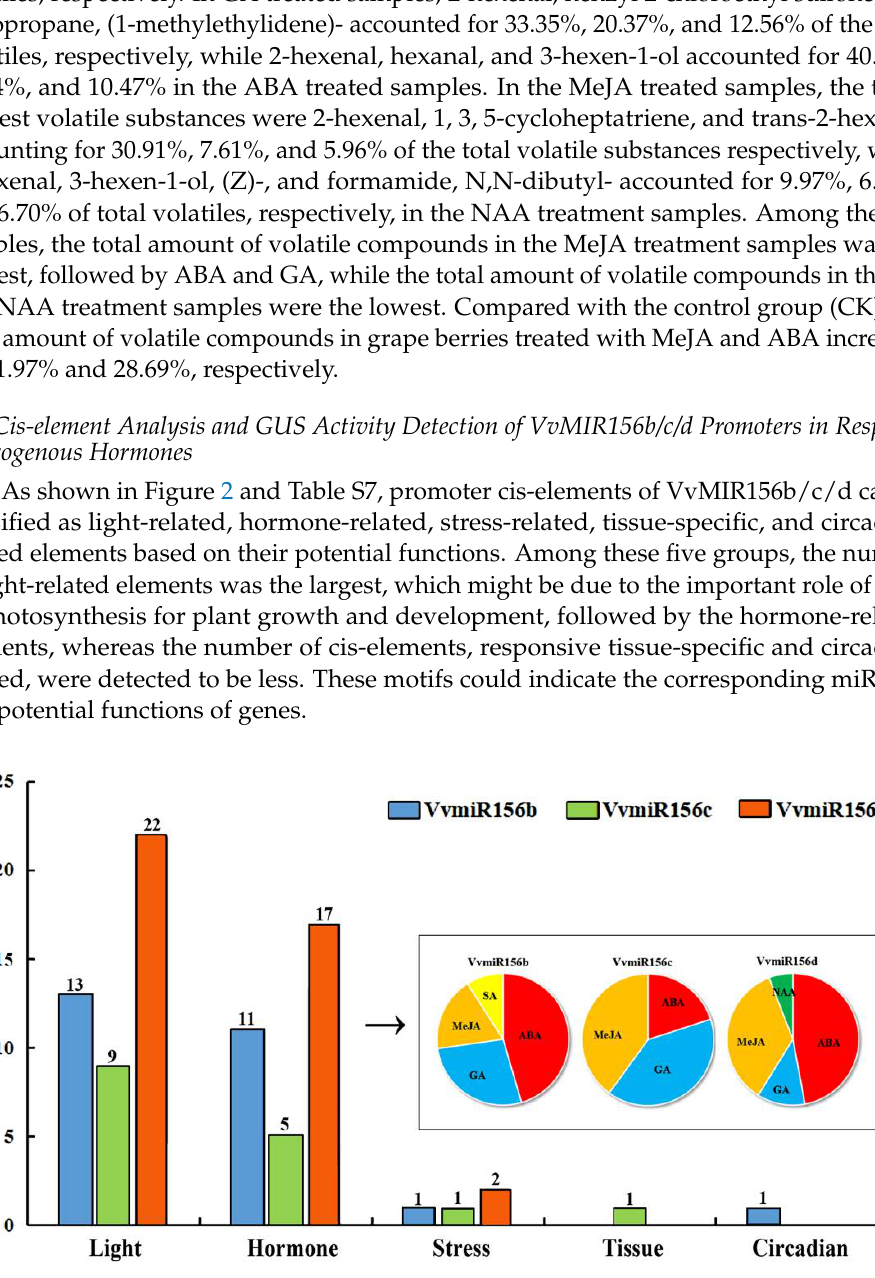
Figure 2. Motif analysis of the VvMIR156b/c/d promoters. Hormone-related motifs in their promoter regions were scanned and it was found that almost all VvmiR156b/c/d had similar hormones-related motifs including the ABA, GA, and MeJA responsive motifs (Figure 2). Furthermore, the SA-responsive element (TCA-element) and auxin-responsive element (TGA-element) in VvmiR156d were also found. Among these hormone-related elements, the number of cis-elements responsive to ABA and MeJA was the greatest, followed by the GA and auxin-responsive elements. This indicated that VvmiR156b/c/d might answer hormone signals and be involved in these several plant hormone-related pathways, and jointly participate in the regulation of grape growth and